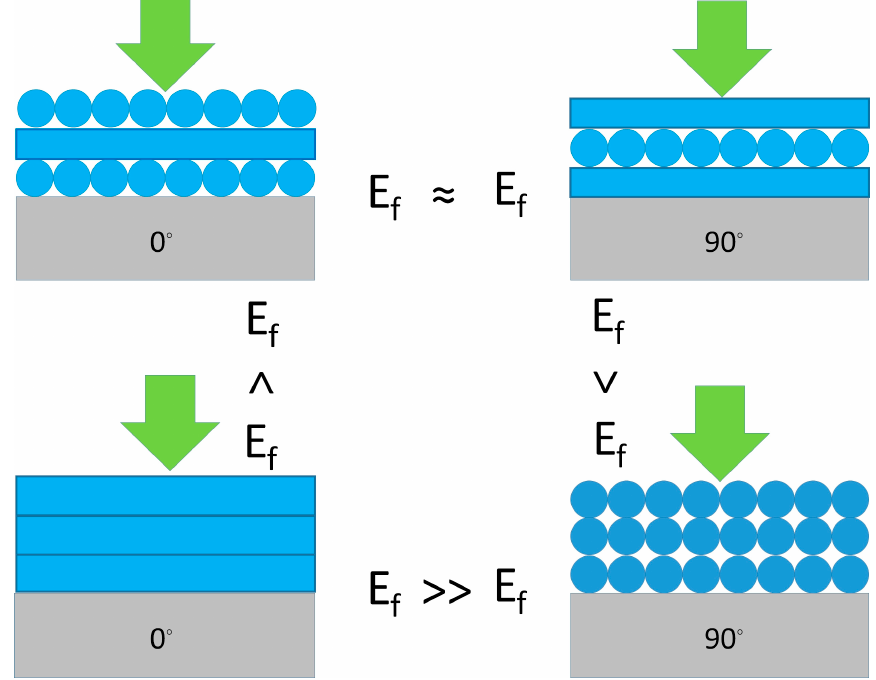
Figure 7. Relationship between the strength of mixed reinforcements.